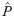
Possible interaction group arrangements.Four independent generations of possible populations consisting of four groups each. Each population produces a different P^ due to a random assortment of cooperators and non-cooperators. As it is more likely that cooperators encounter other cooperators, P^ increases.